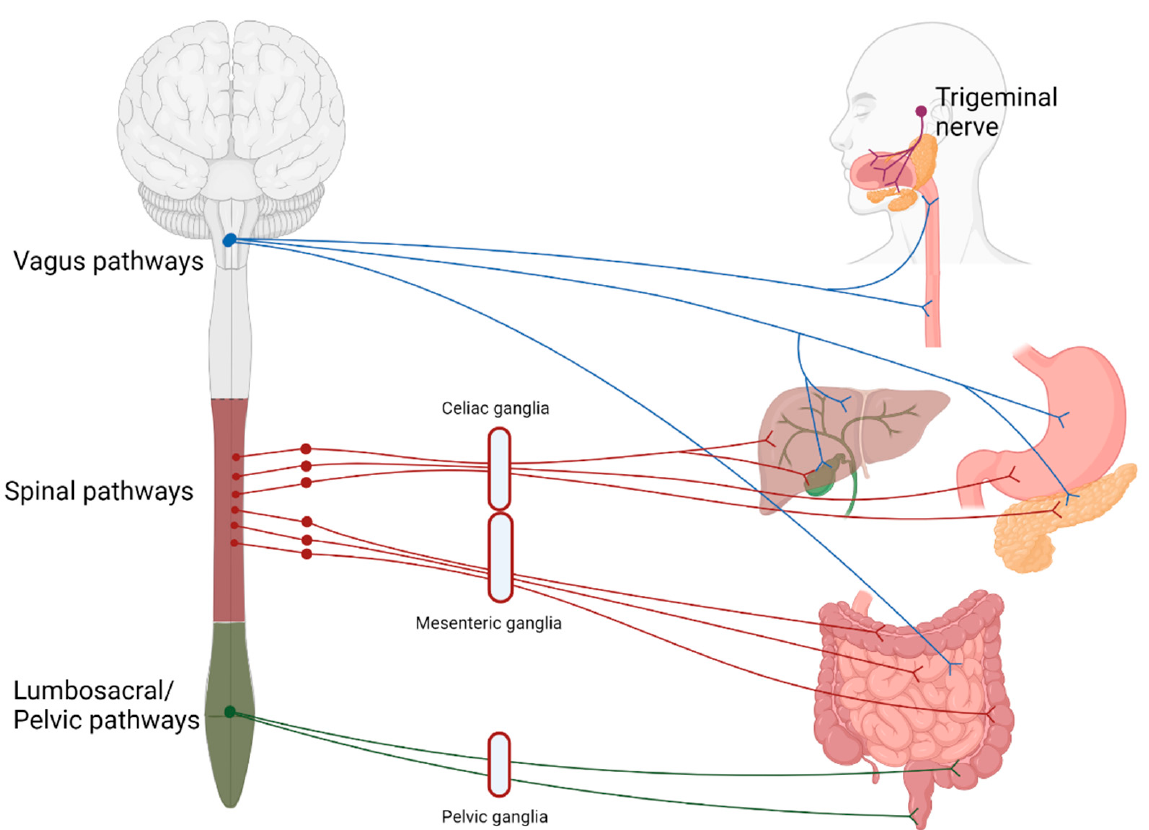
Figure 1. Schematic representation of the extrinsic innervation of the digestive system. Sympathetic innervation is performed mainly by spinal nerves (red), while parasympathetic by the vagal (blue) and pelvic branches (green). Both the spinal and vagal pathways are also involved in sensory and motor innervation. The trigeminal branches (purple) serve primarily sensory and motor functions.